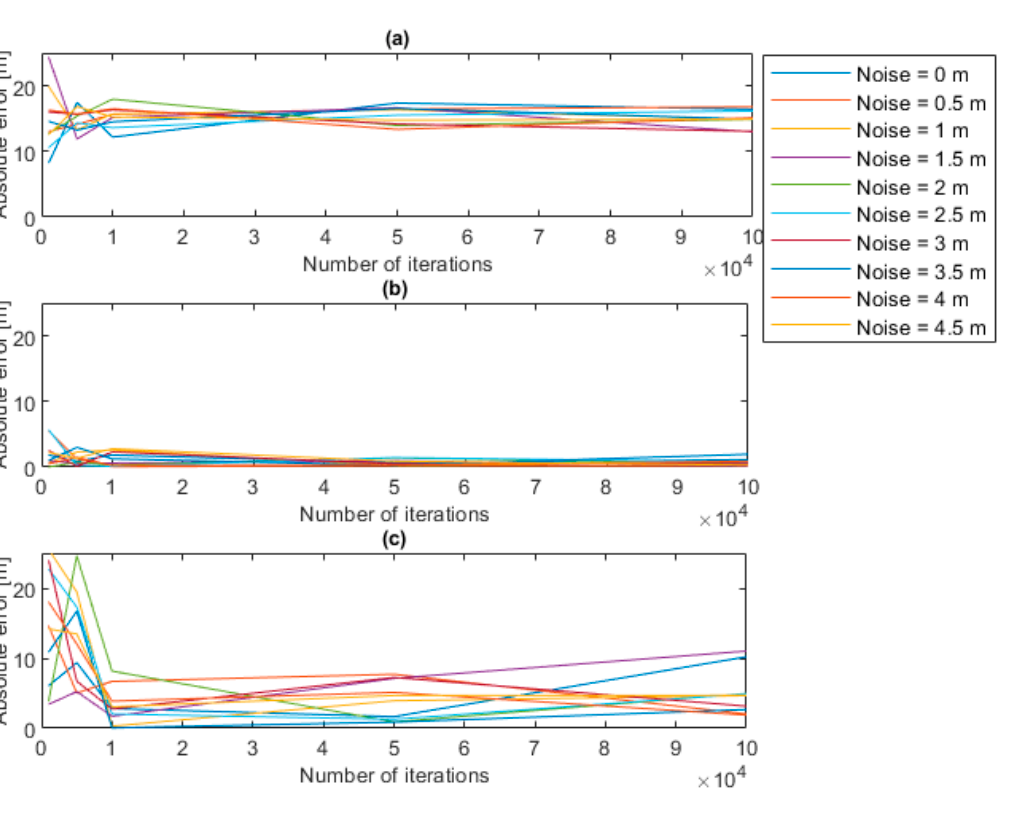
Figure 10. Error trends for different noise levels ( a ) 1,000 iterations, ( b ) 10,000 iterations, ( c ) 100,000 iterations.